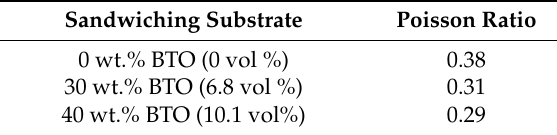
Table 4. Poisson’s ratio of the substrate when strained.